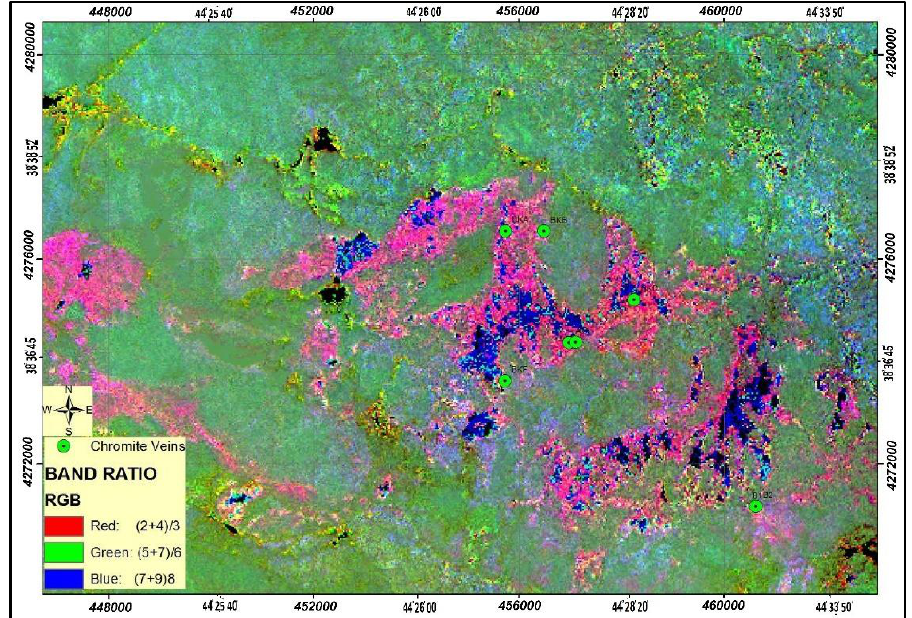
Figure 14. The RGB image of band ratios (2 + 4)/3, (5 + 7)/6, (7 + 9)/8 in the study area. Chromite outcrops and veins are shown on the map.